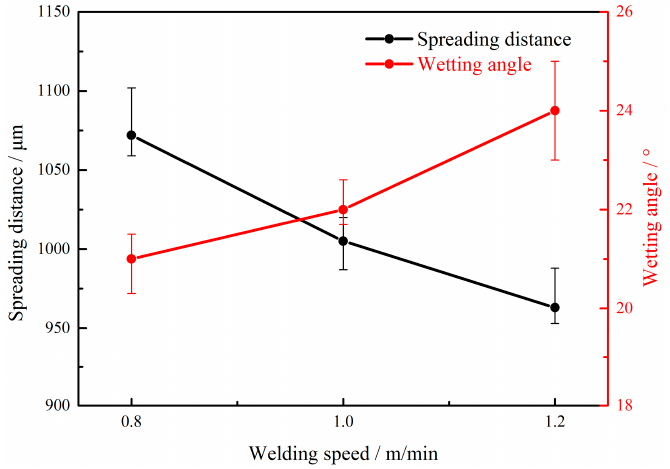
Figure 8. Spreading distance and wetting angle with different welding speeds.